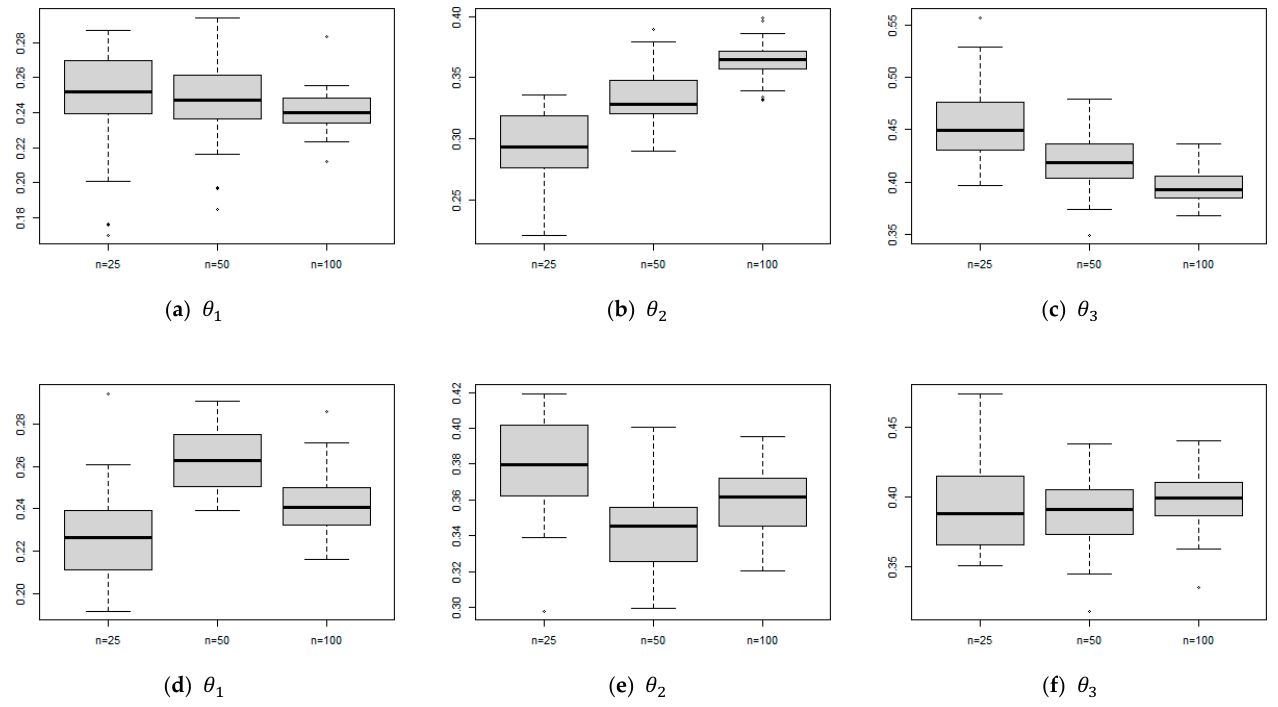
Figure 2. Side-by-side box plots depicting the extent of variability observed in the estimation of worth parameters; top panel projects the variation for τ = 0.10, whereas lower panel shows the behavior for τ = 0.20. The * indicates the presence of outliers.